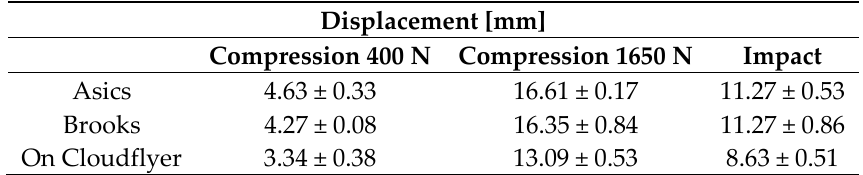
Table 2. Results of mechanical tests of the three running shoes under three test conditions. The values represent the mean displacement in mm, evaluated after ten cycles per test